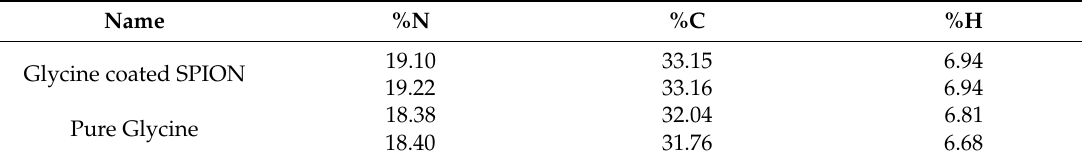
Table 1. C, H, N analysis to determine glycine coating on nanoparticle